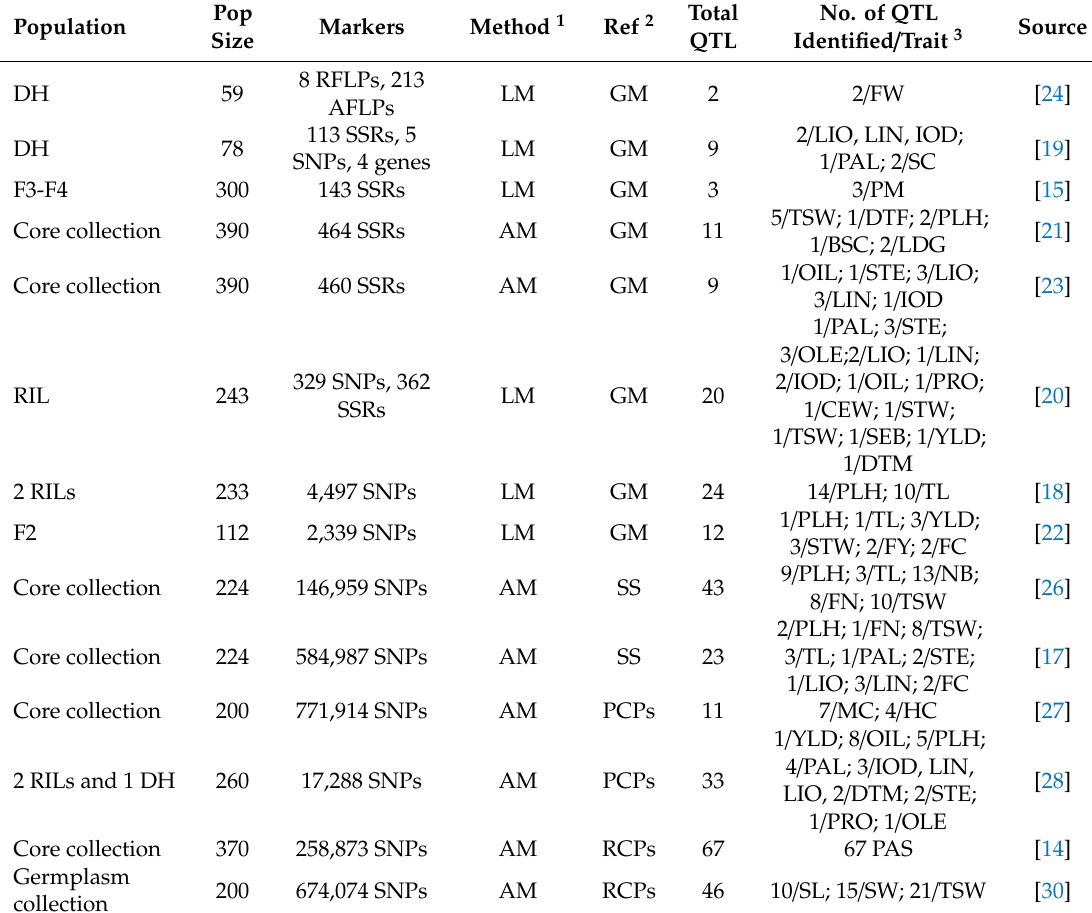
Table 2. QTL identification studies in